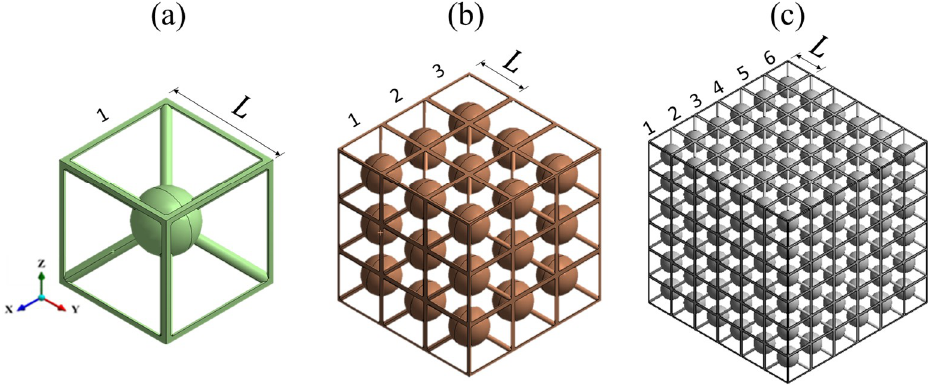
Figure 13. Res-BCC xyz lattice structures of finite periodicities of ( a ) one, ( b ) three and ( c ) six.